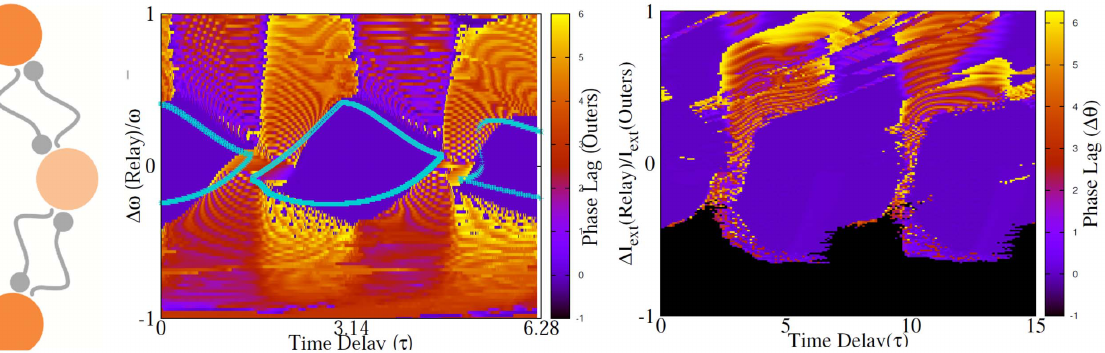
Fig. 6. Symmetric relay system with inhomogeneous firing rates. Synchronization of the outer neurons when the relay neuron has different firing rate. In the right figure the analytic result for the borders of stable synchrony for phase oscillators is shown with blue thick lines and the numerical results for the phase lag are presented by the color code. Vertical and horizontal axis show the relative difference of the firing rate of the relay neuron (with outer neurons) and the delay time, respectively. Zero lag synchrony is coded by blue. In the right panel the numeric results are shown for HH neurons. In this case inhomogeneity is applied by changing the input current (which controls the inter-spike-interval of the